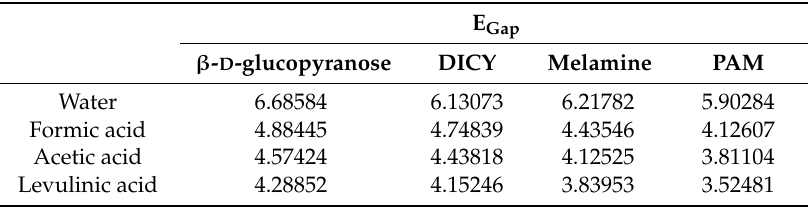
Table 2. Reactant molecules (eV).